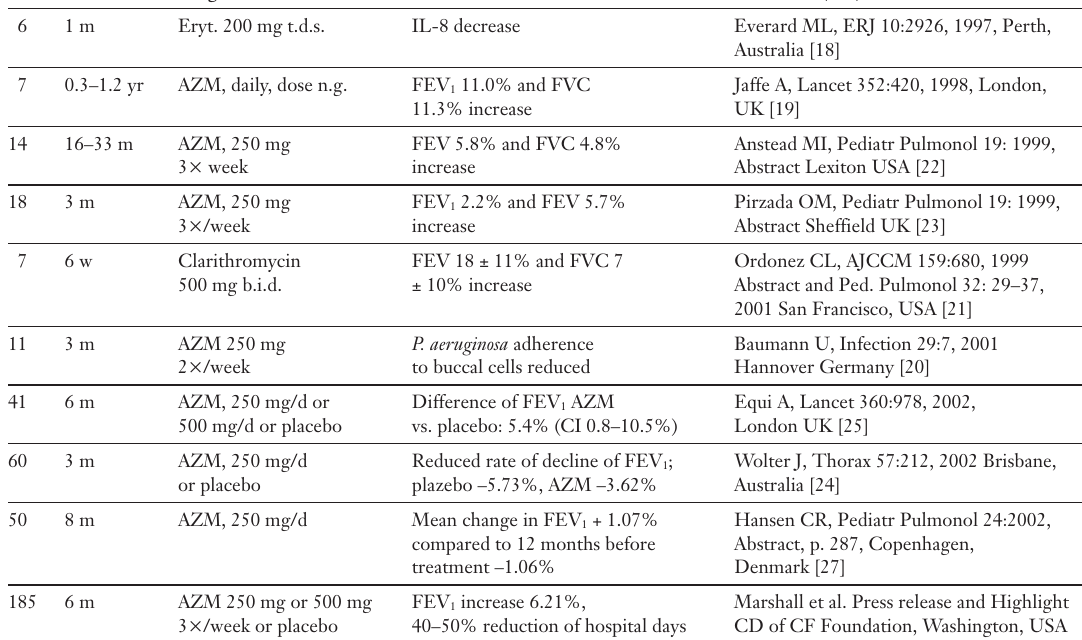
Table 1 Published studies about macrolides and cystic fibrosis includ- ing press released and reported data of the US trial [26]. References of the studies see